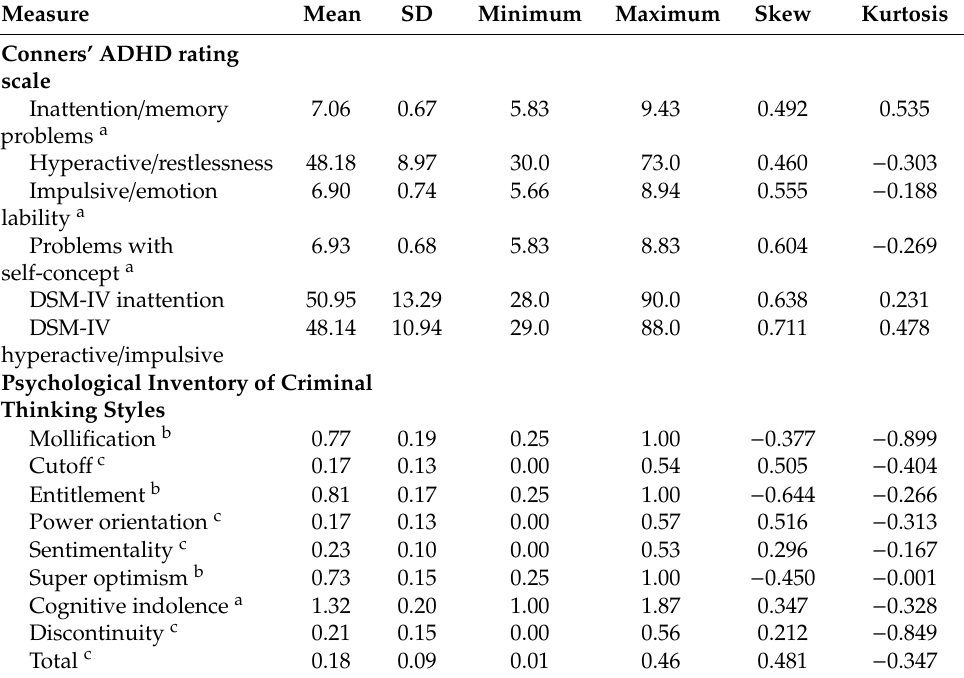
Table 3. Descriptive statistics for the Conners’ Adult ADHD rating scale and the Psychological Inventory of Criminal Thinking Styles ( N =